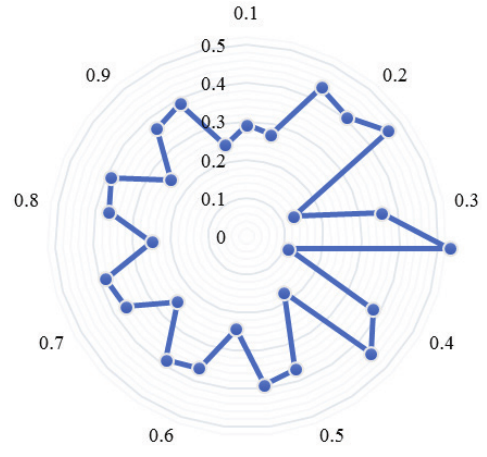
Figure 4. Eff ect of changing D p value in the weighting method